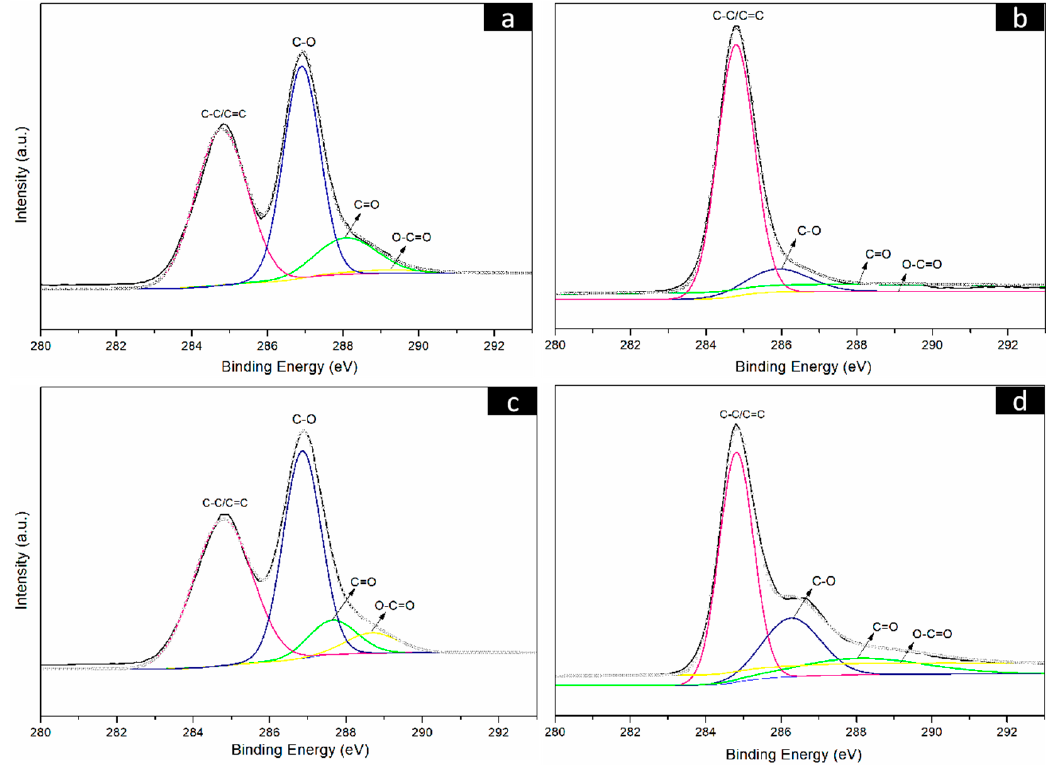
Figure 4. C1s spectra of the GO ( a ), RGO ( b ), CNFs/GO 12 ( c ) and CNFs/RGO 12 ( d ) films.